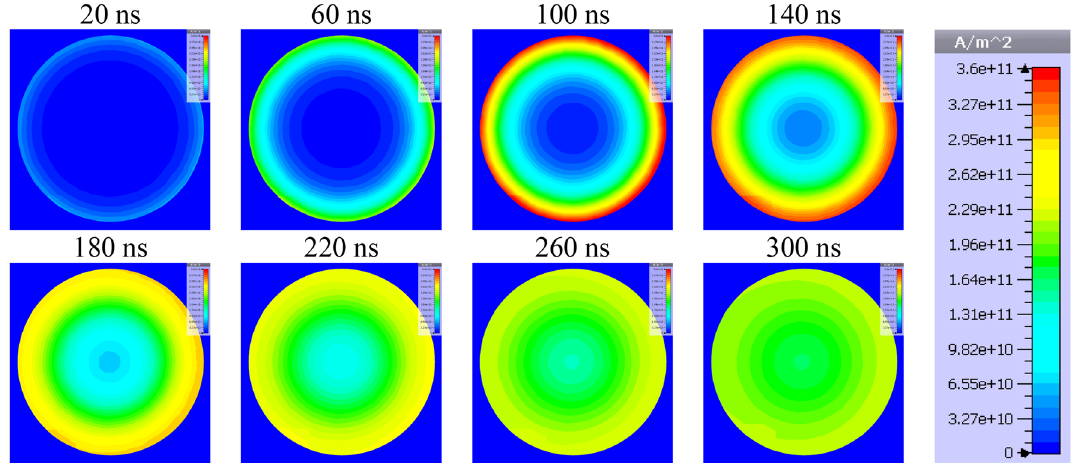
Figure 9. Visualization of dynamic distribution of current density in the cross-section of a silver fusible element with a diameter of 0.25 mm during the flow of current with significant steepness.